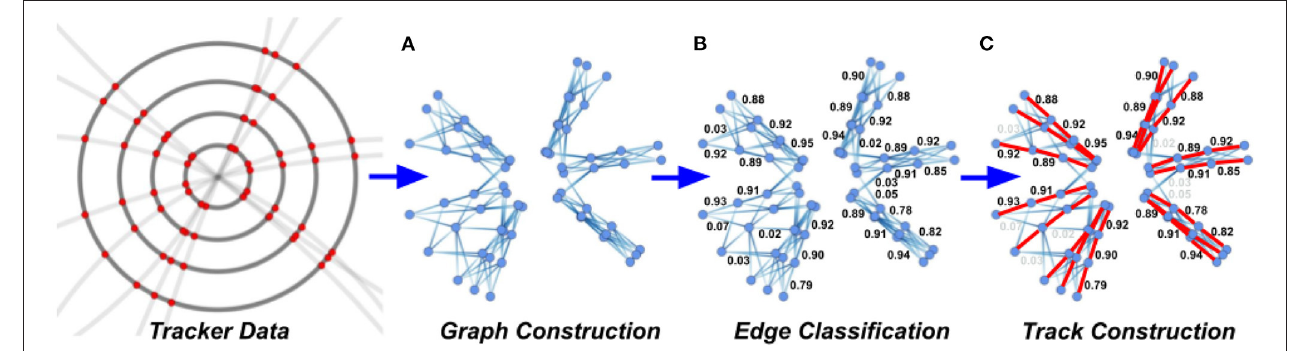
FIGURE 2 | High-level overview of the stages in a GNN-based tracking pipeline. Only a subset of the typical edge weights are shown for illustration purposes. (A) Graph construction, (B) edge classification, and (C) track